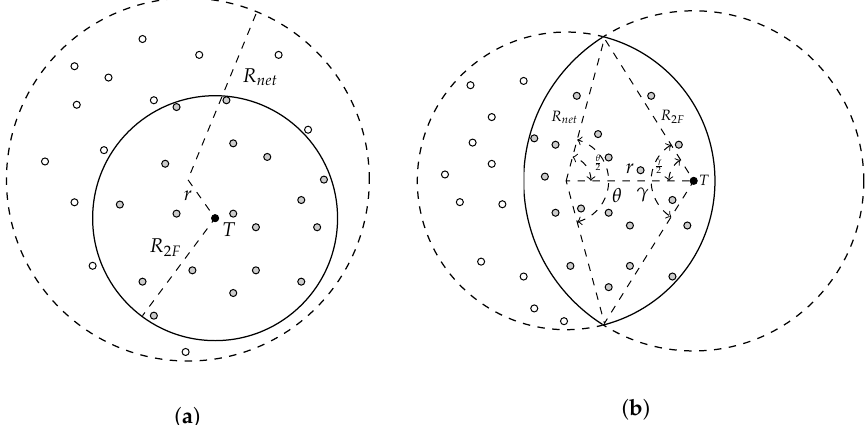
Figure 4. Maximum area (solid line) where launching a chase flooding generates similar overhead compared with traditional flooding. ( a ) Disk shaped network; ( b ) Lens shaped